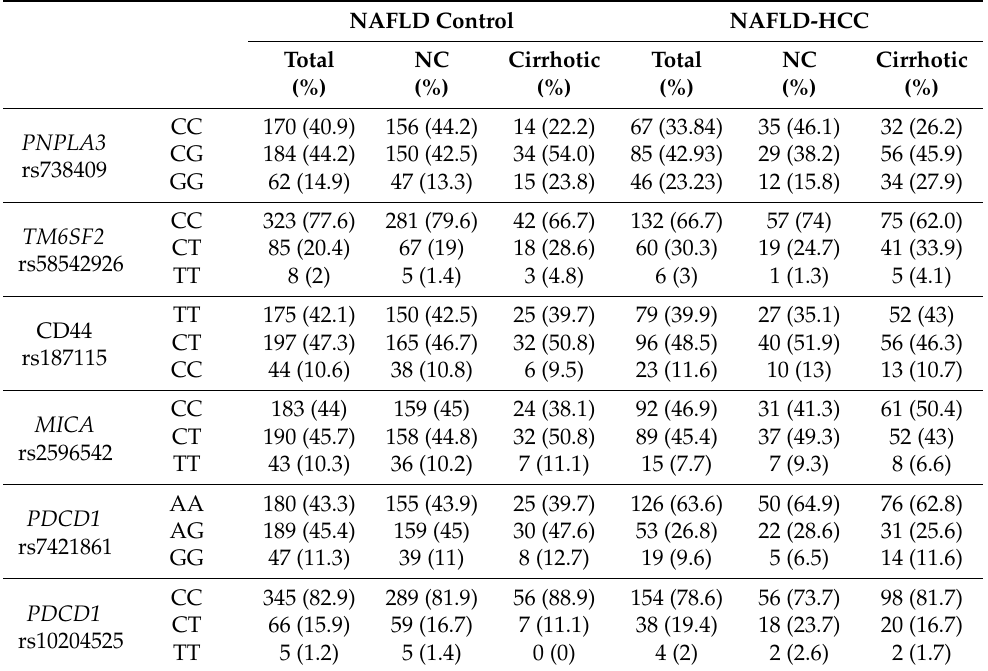
Table 3. Genotype distribution between cirrhotic and non-cirrhotic (NC) NAFLD and NAFLD- HCC